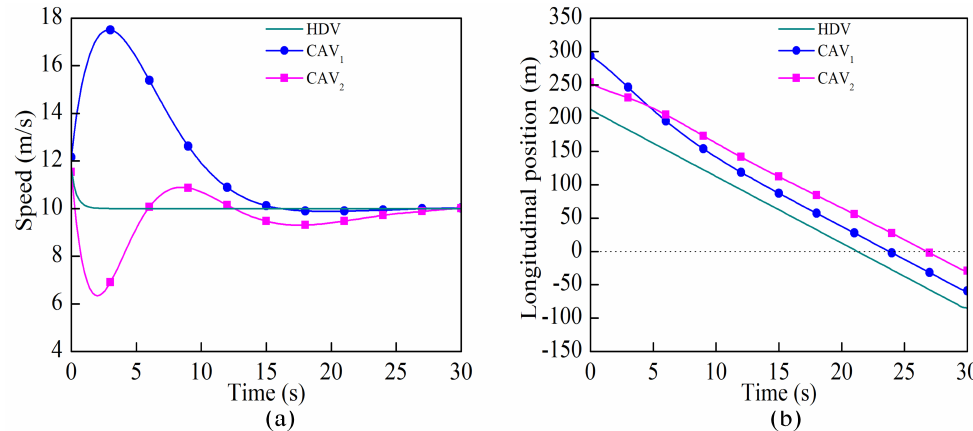
Figure 10. The speed and position curves of all the vehicles in the ideal traffic using the heuristic rule-based algorithm; ( a ) the speed, ( b ) the position.